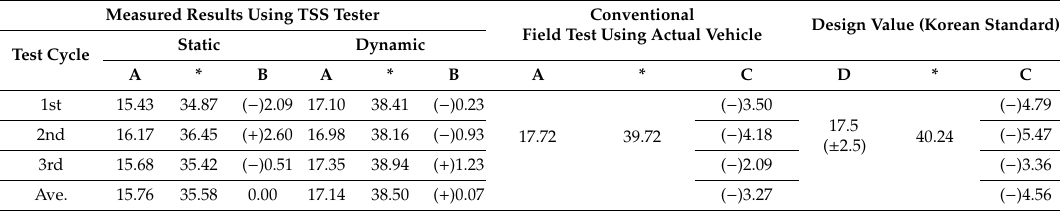
Table 1. Comparisons of measured track support sti ff ness and predicted spring sti ff ness of resilient pad by testing methods. Measured Results Using TSS